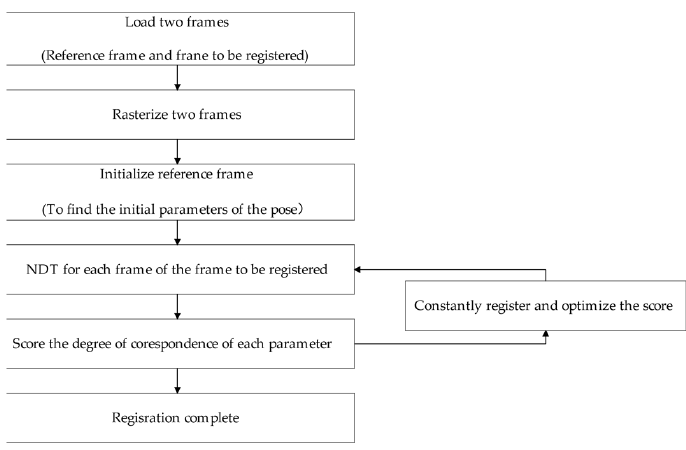
Figure 3. The flow of the NDT registration algorithm.